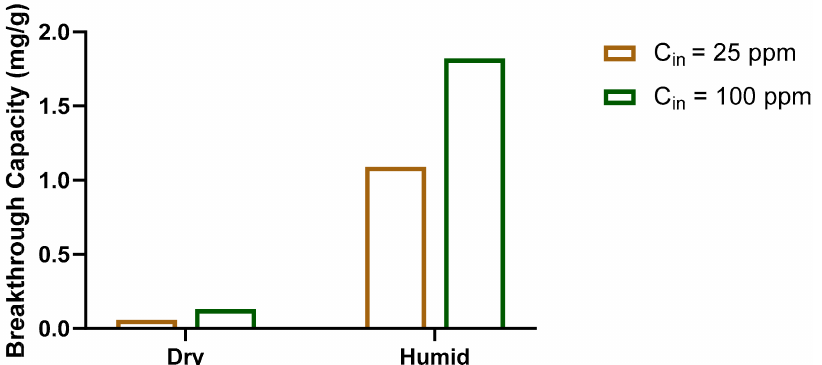
Figure 4. Impact of influent concentration on the 50% breakthrough sorption capacity of biochar under dry (RH = 3.4%) and humid (RH = 55.9%) conditions (C in = influent H 2 S